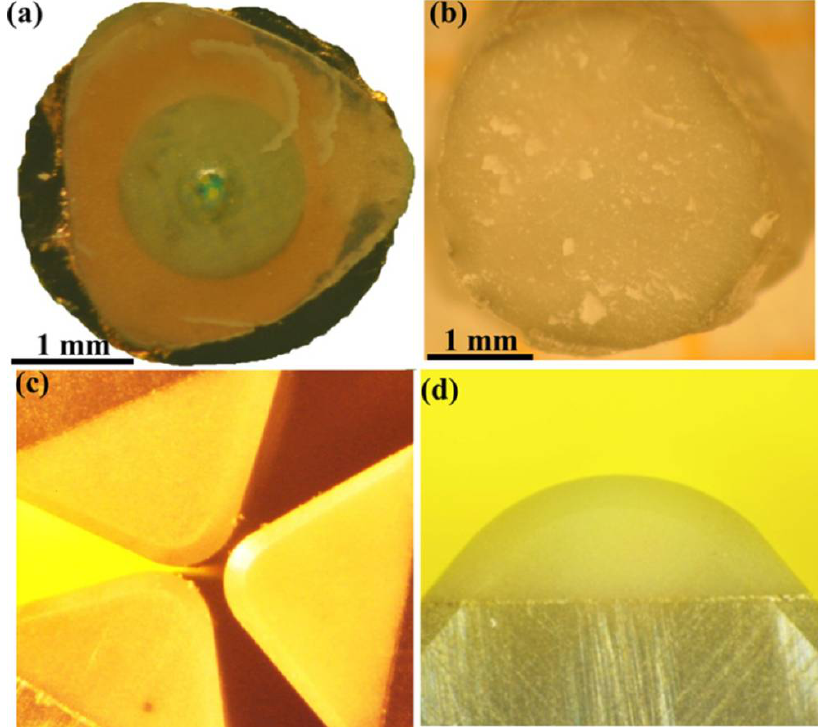
Figure 8. Photographs of diamond-cBN bulk samples and diamond-cBN alloy cutters. ( a ) and ( b ) Bulk diamond–cBN alloy samples synthesized at 20 GPa/2500 K with a diameter of ∼ 3 mm, over a copper screen to exhibit its transparency. ( c ) and ( d ) Polished rake faces of diamond–cBN alloy cutters. Reproduced from Wang et al. “Diamond-cBN alloy: A universal cutting material.” Appl. Phys. Lett. 107, 101901 (2015), with the permission of AIP Publishing. The diamond– c BN alloy bulk sample synthesized at 19 GPa/2000 °C has a Vickers hardness of 78 ± 5 GPa under a load force of 9.8 Newtons, a value close to the hardness of single-crystal diamond ( H V : 60–120 GPa) and far exceeding the hardness of single-crystal c BN ( H V ~ 50 GPa) [12,14]. The onset oxidation-temperature for diamond– c BN alloys (1070 K) is more upper than that of PCD (869 K) but more inferior than that of c BN (1343 K). X- ray photoelectron spectroscopic (XPS) measurements confirmed new B–C and C–N bonds in diamond- c BN alloys that are presumably produced at or near diamond– c BN grain boundaries.